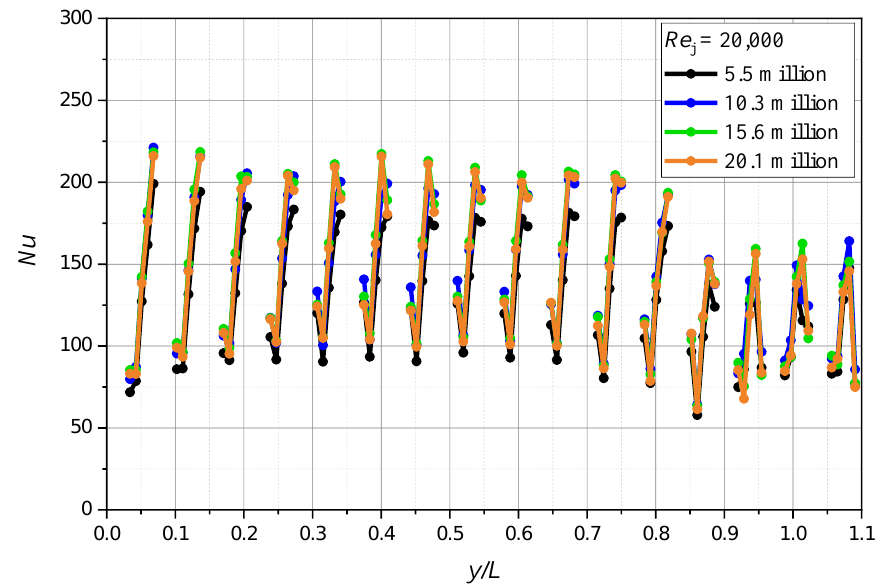
Figure 6. Effect of fluid grids size on Nusselt number at the stagnation line of the target surface.